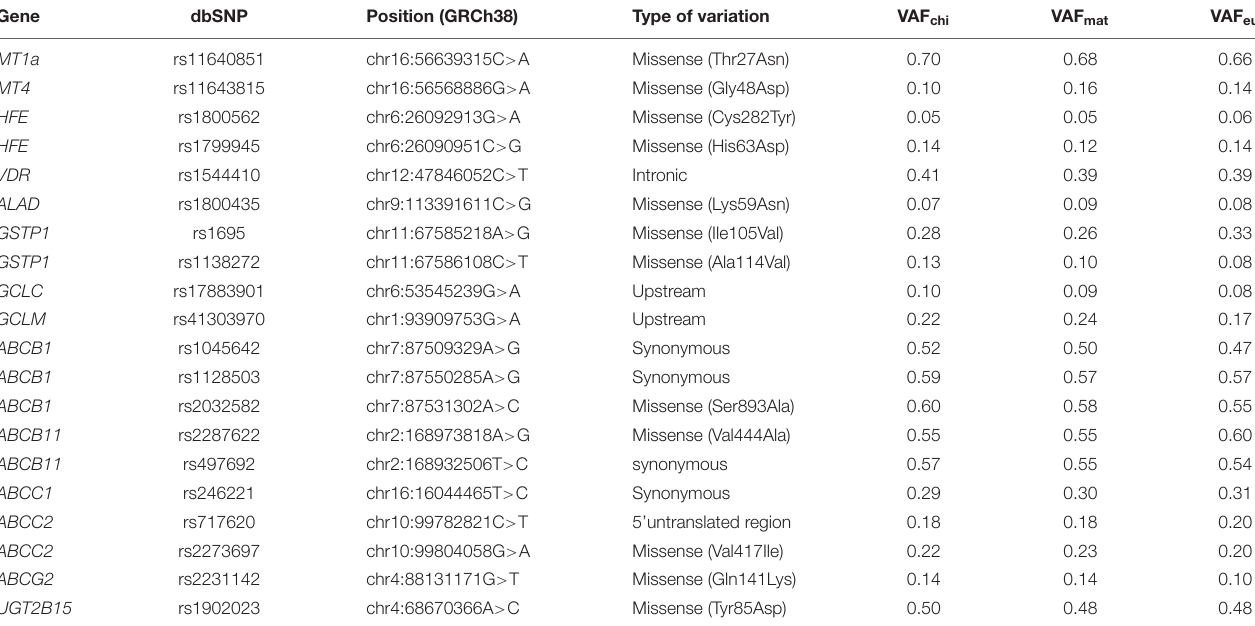
TABLE 2 | Nomenclature of examined polymorphisms and variant allele frequencies in 200 mother-child